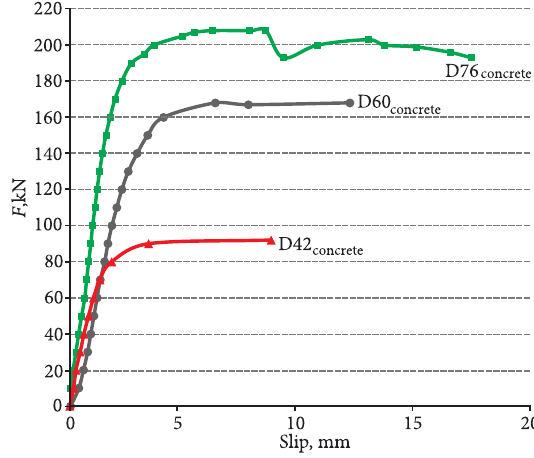
Fig. 8. Force-slip graph of the connectors with a concrete in-fill core